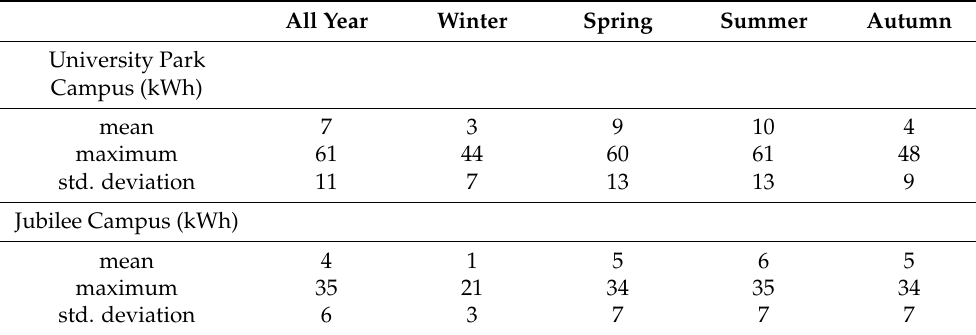
Table 8. Renewable energy generation from photovoltaics at the University Park and Jubilee campuses (kWh per 30 min).